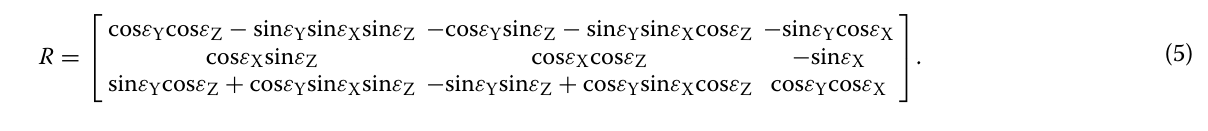
(2) In coordinate system O ′ - X ′ Y ′ Z ′ , the cube ABCD- EFGH is established, which constructs the information space network N ′ ( V ′ , E ′ ) shown in Figure 4. In the net- work, the ABCD surface of the cube, which is basically a square plane with side length of L , is on X ′ Z ′ plane. Side AB coincides with X ′ axis, side BC// Z ′ axis, and the original point O ′ and point A are in the same position.